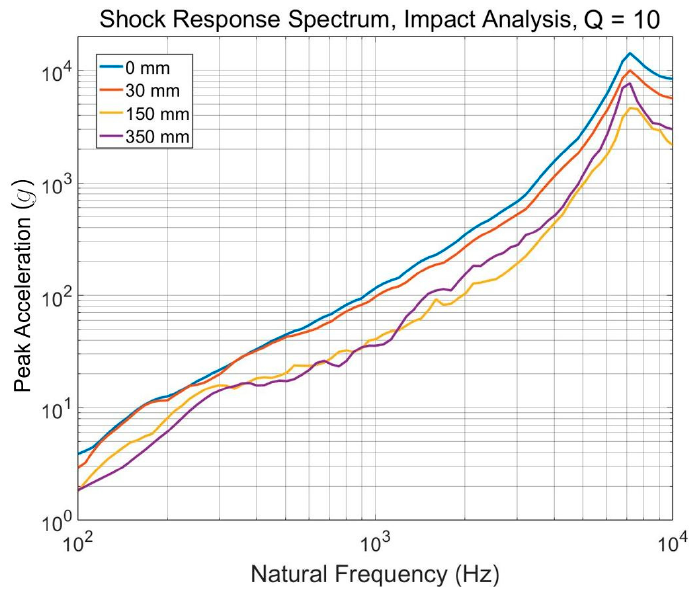
Figure 12. SRS of impact analysis when steel ball collides with 7 kHz resonator at 80 m/s.